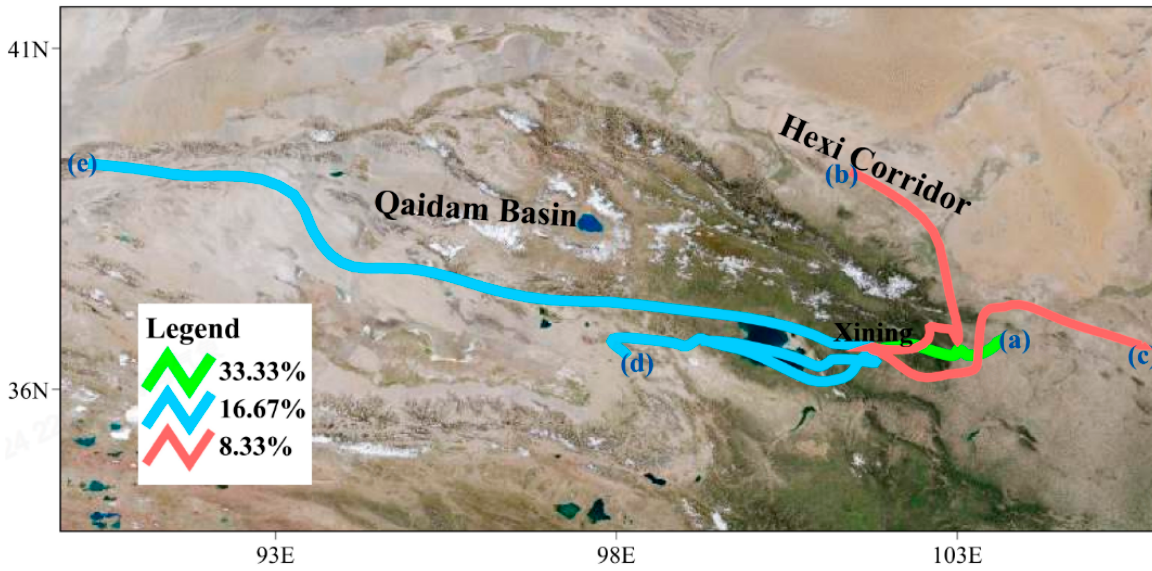
Figure 7. Cluster analysis of HYSPLIT backward trajectory in Xining City during March 2021.